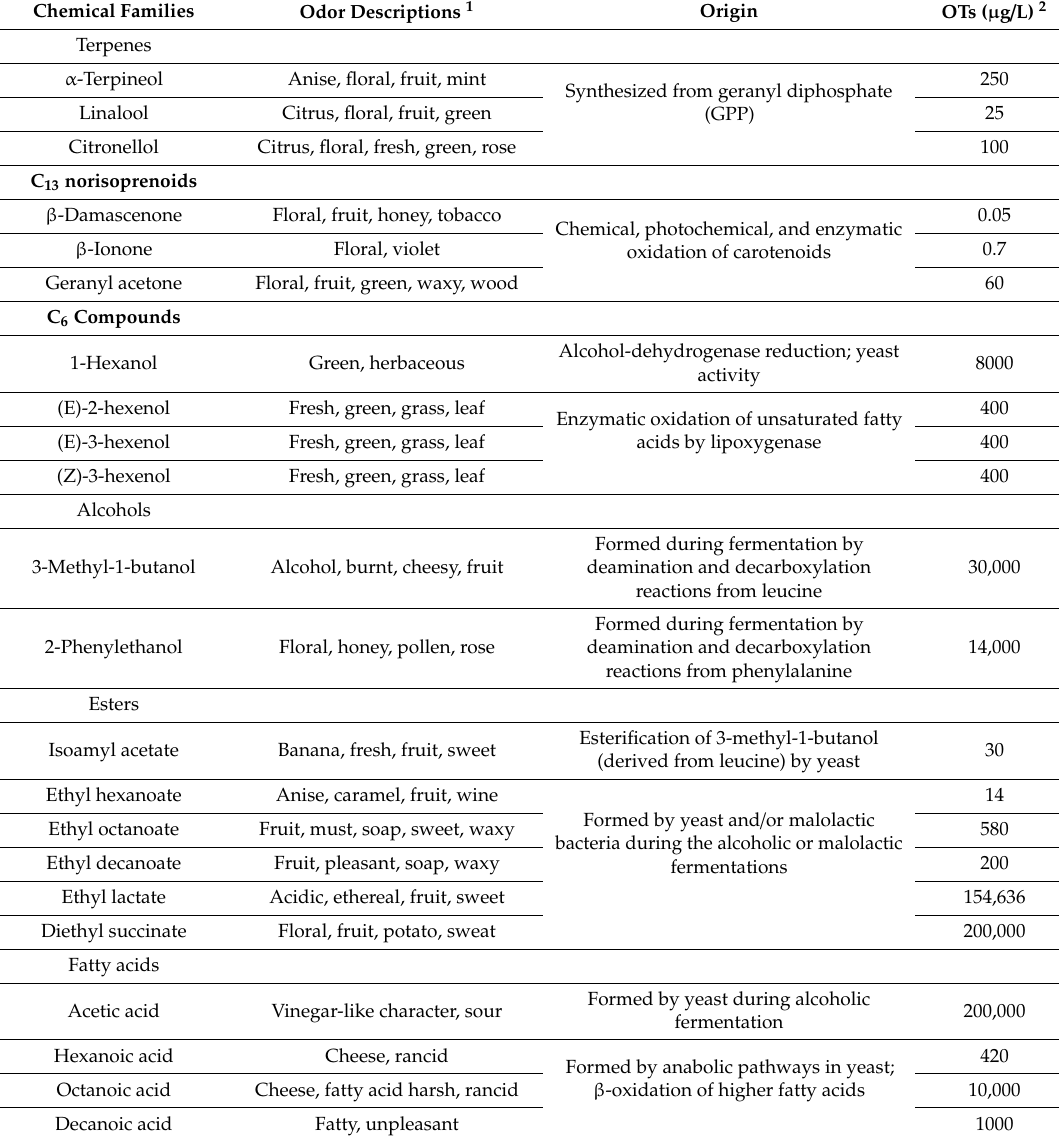
Table 1. Predominant volatile organic compounds (VOCs) found in Madeira wines, odor